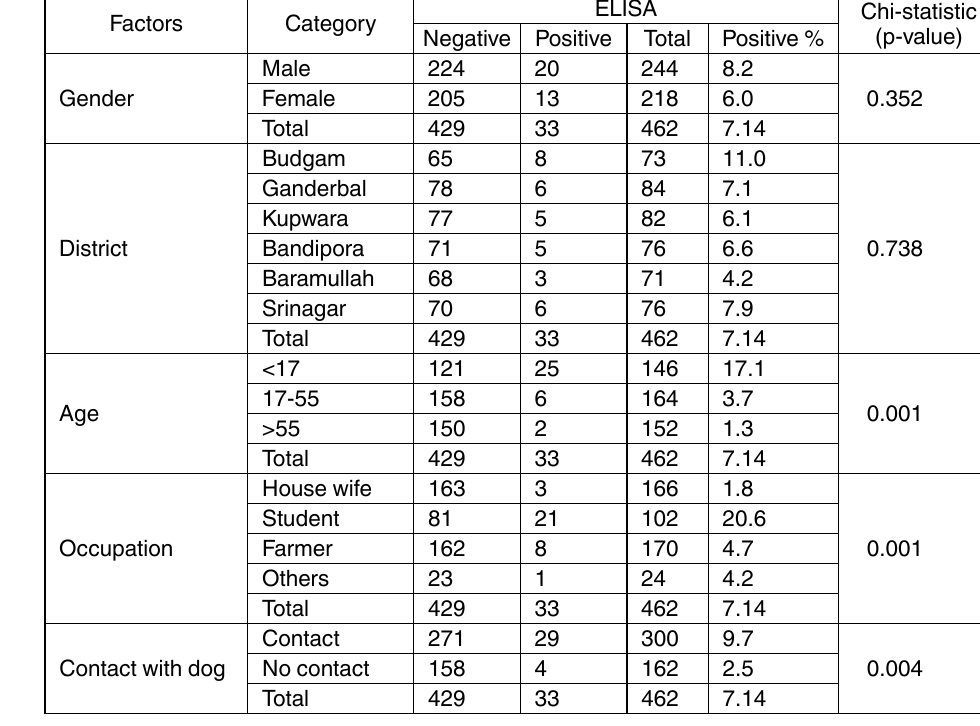
table 1. Seropositivity of cystic echinococcosis in different groups of Central and North Kashmir